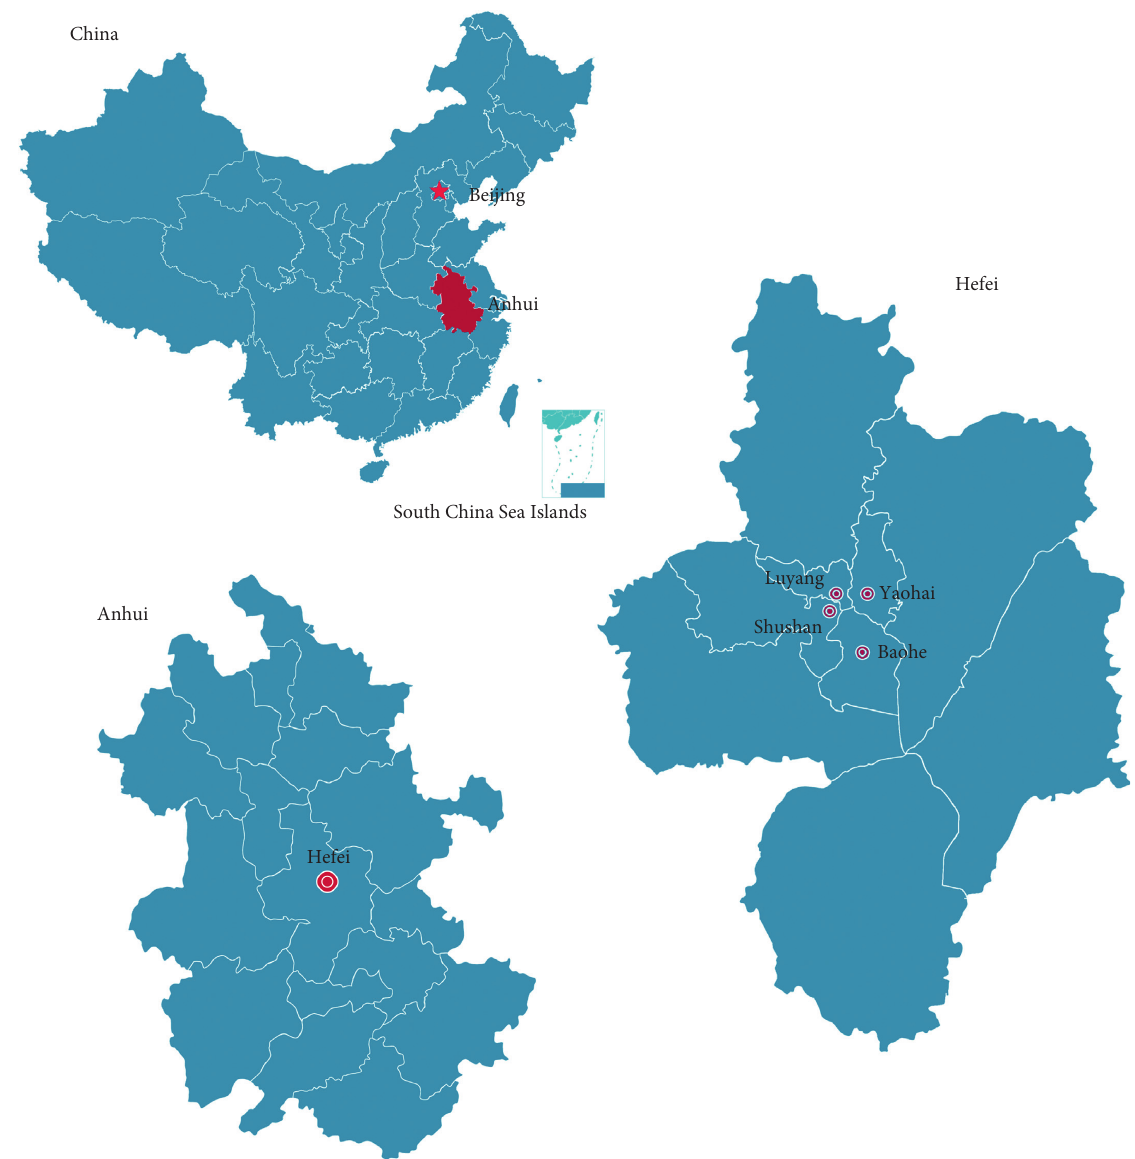
Figure 2: The study area: Hefei in Anhui Province,